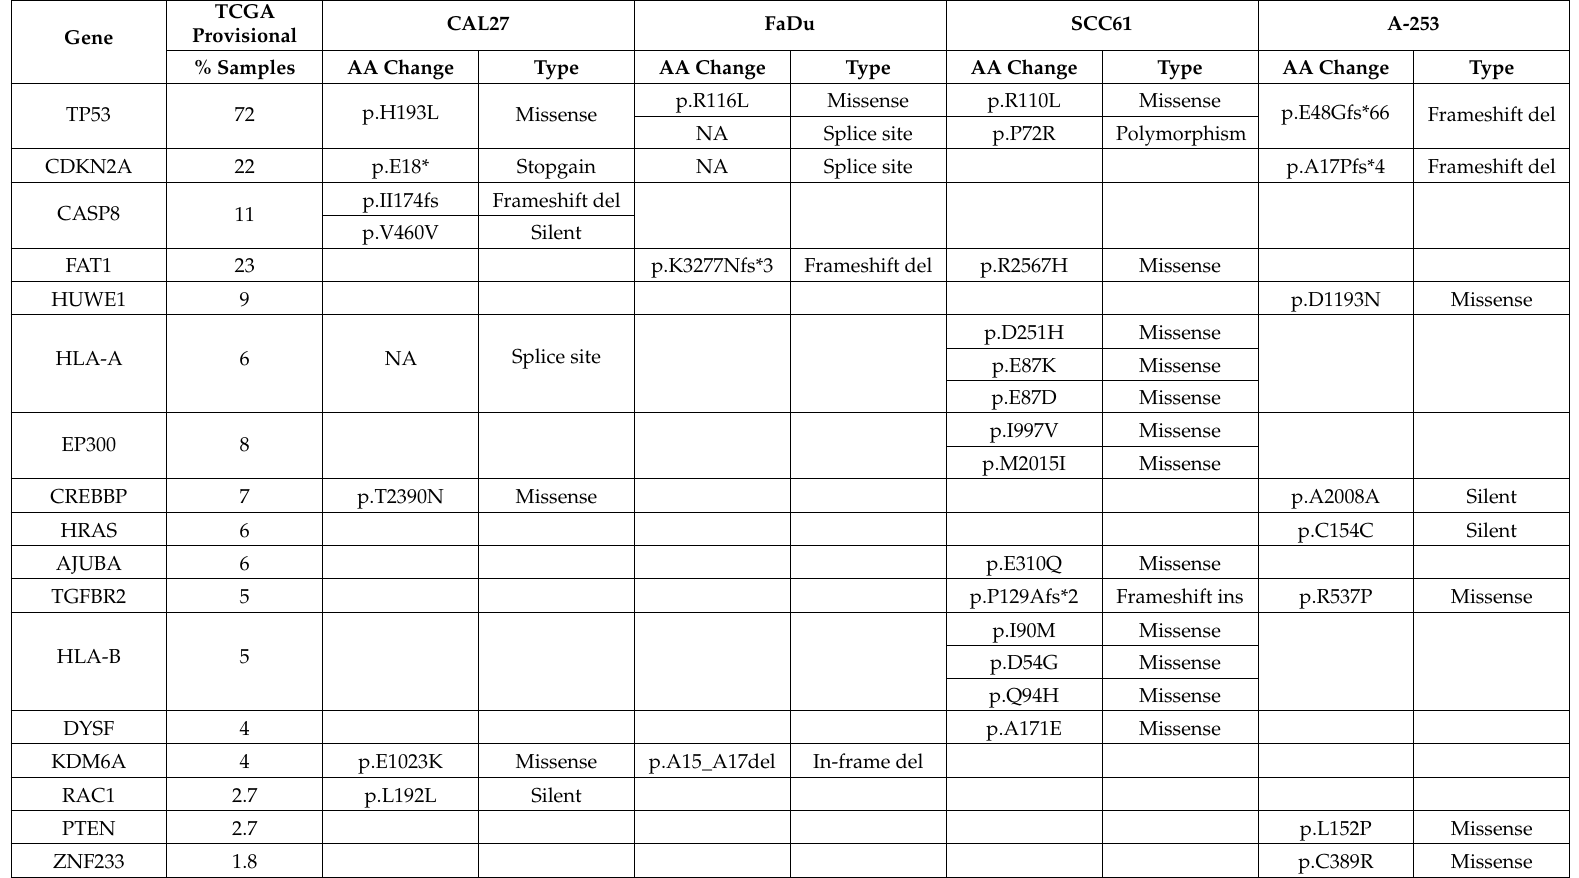
Table 1. Mutational profile of cell line models. For models shown in the study, mutational profile is provided, in reference to frequency of most commonly mutated genes in HNSCC, based on analysis of HNSCC provisional dataset (as of November 2019). Mutations were called as likely damaging (red) versus likely tolerated or of uncertain significance (black) based on use of pathogenicity prediction scores obtained through Annovar (see Methods) and variant annotations accessible in publicly available databases, including the Cancer Cell Line Encyclopedia (CCLE), gnomAD, ClinVar, and OncoKB. SCC61 contains a polymorphism, P72R, associated with altered TP53 function